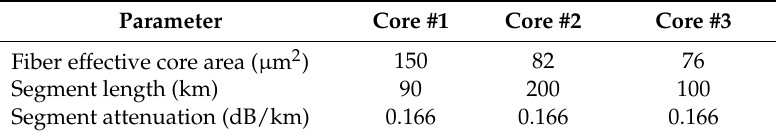
Table 2. Three-segment hybrid fiber core structure.